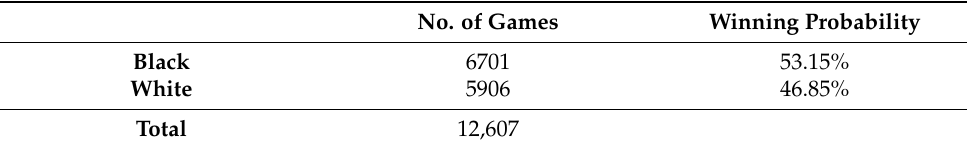
Table 1. Example Go game statistics with a komi of 5.5 (adopted from